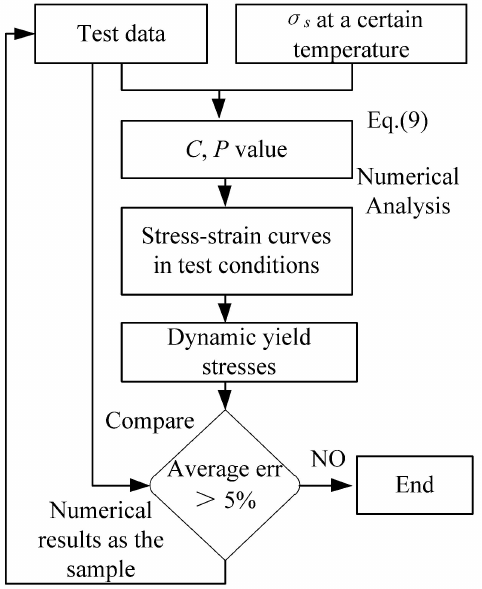
Figure 14. Flowchart of the iterative approximated